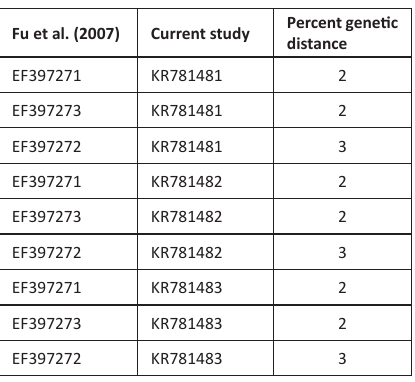
Table 2. K2P distance between S. boulengeri from Fu et al. 2007 and the current study. Fu et al.